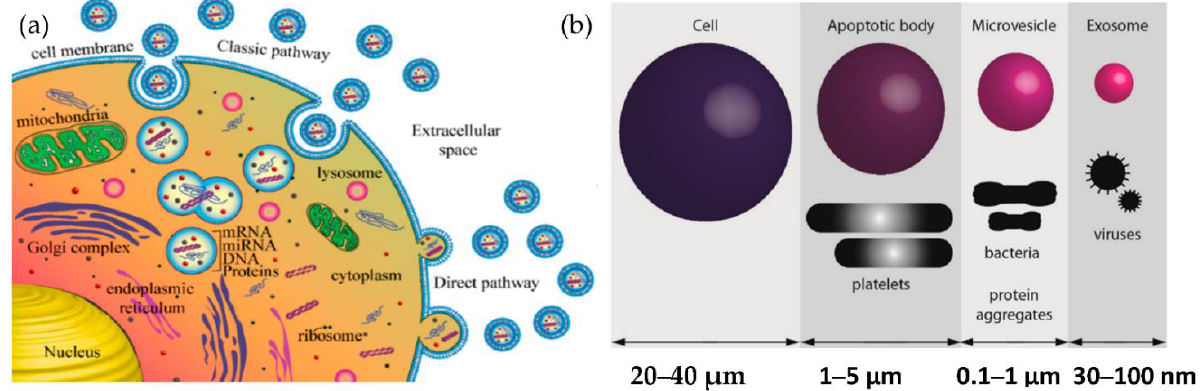
Figure 1. Biogenesis of extracellular vesicles ( a ) Exosome biogenesis ( b ) Comparison of the size of various types of extracellular vesicle with that of a cell.